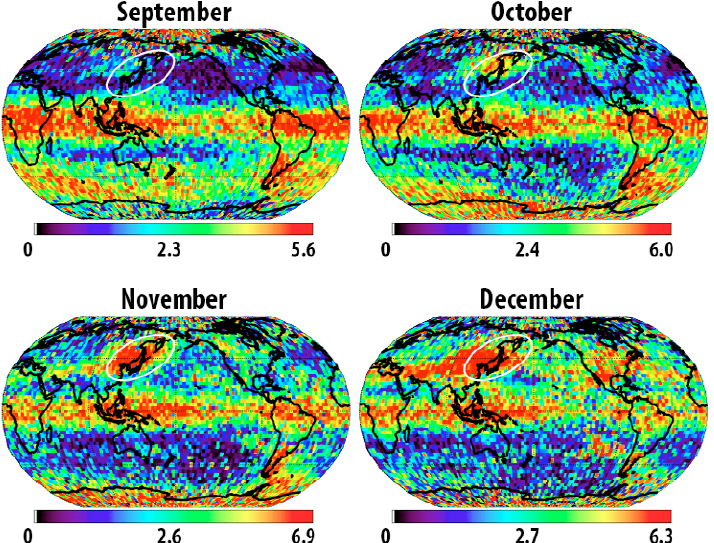
Figure 5. Selected monthly means of the potential energy in Jkg − 1 averaged across the whole vertical profile for 2007–2010 (non-linear colour scale